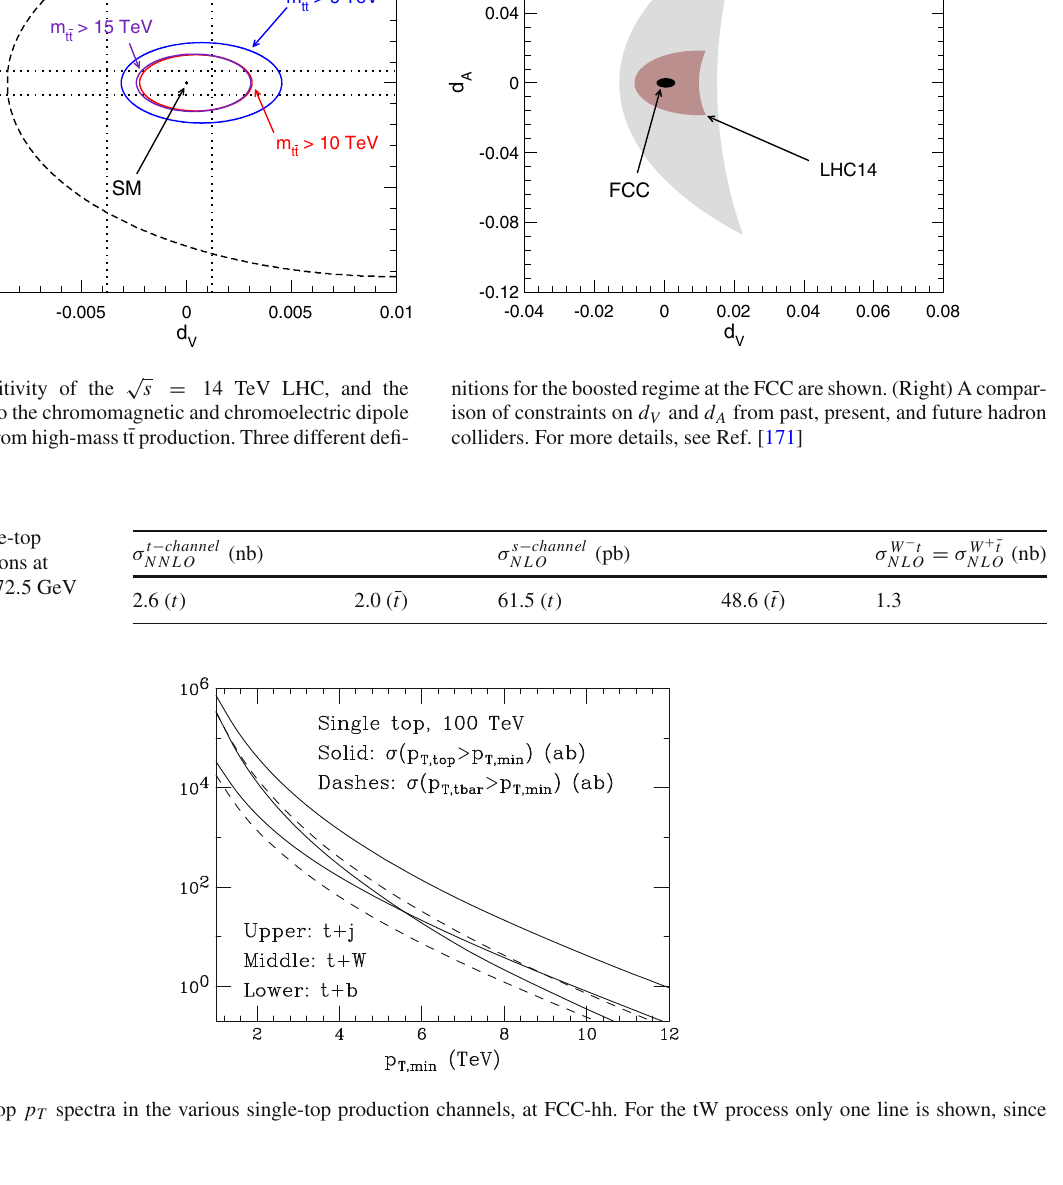
a reduction factor of O (10) is required to suppress the t and t ¯ t jet backgrounds to the level of single top final states. Detailed studies of possible applications are not yet